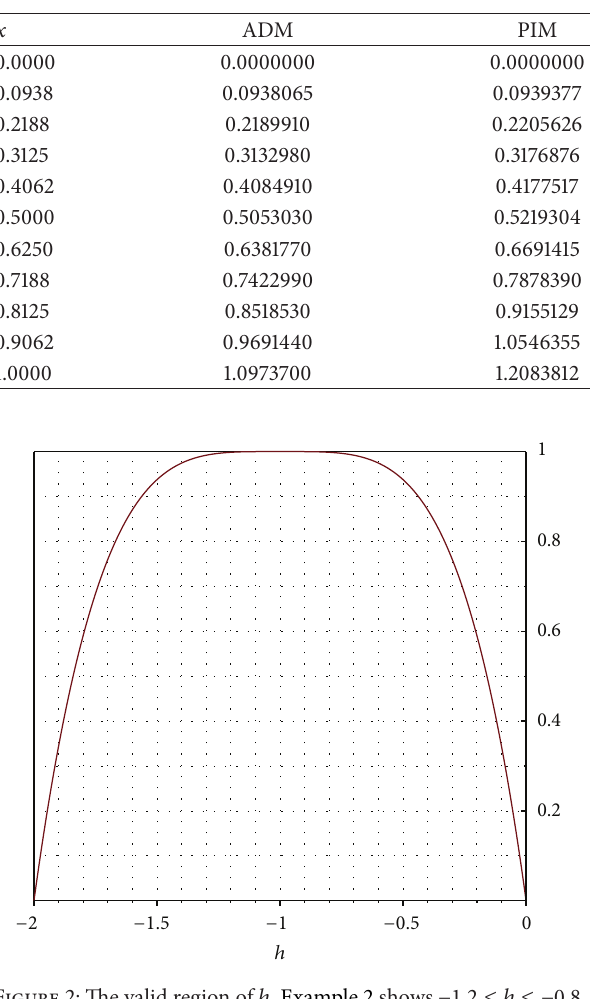
Figure 2: The valid region of ℎ . Example 2 shows −1.2 ≤ ℎ ≤ −0.8